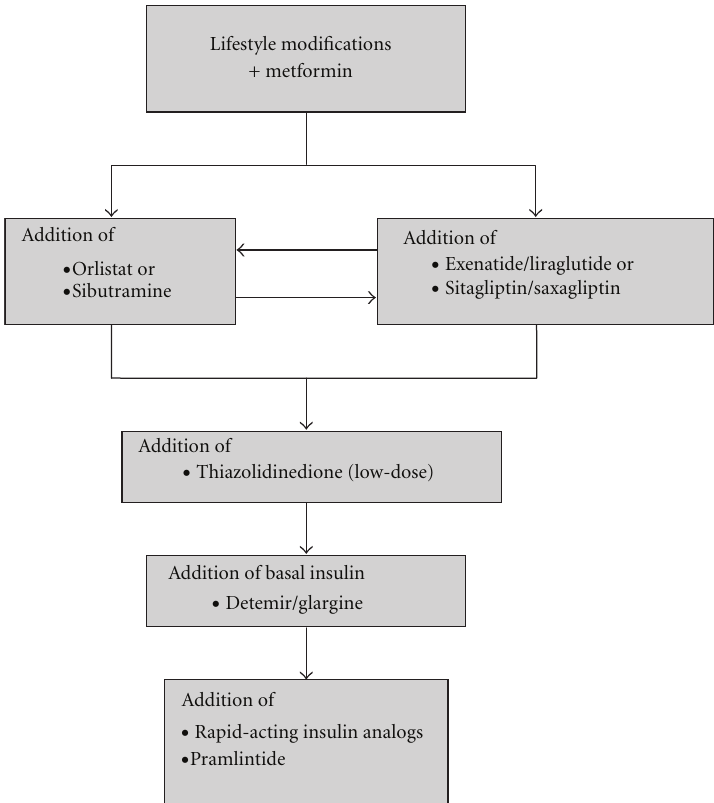
Figure 2: Practice-based approach for balancing weight loss and glycemic control (HbA1c < 7%) in uncomplicated type 2